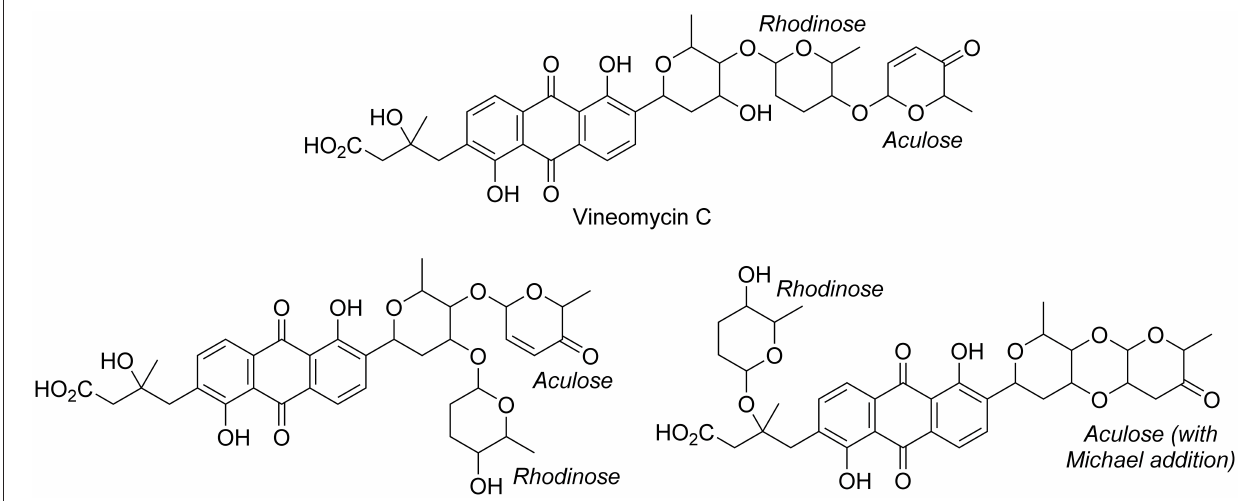
FIGURE 3 | Published structure of vineomycin C and putative structures for compound 6a. The sugar groups annotated as rhodinose are either rhodinose or amicetose (indistinguishable stereoisomers in MS).